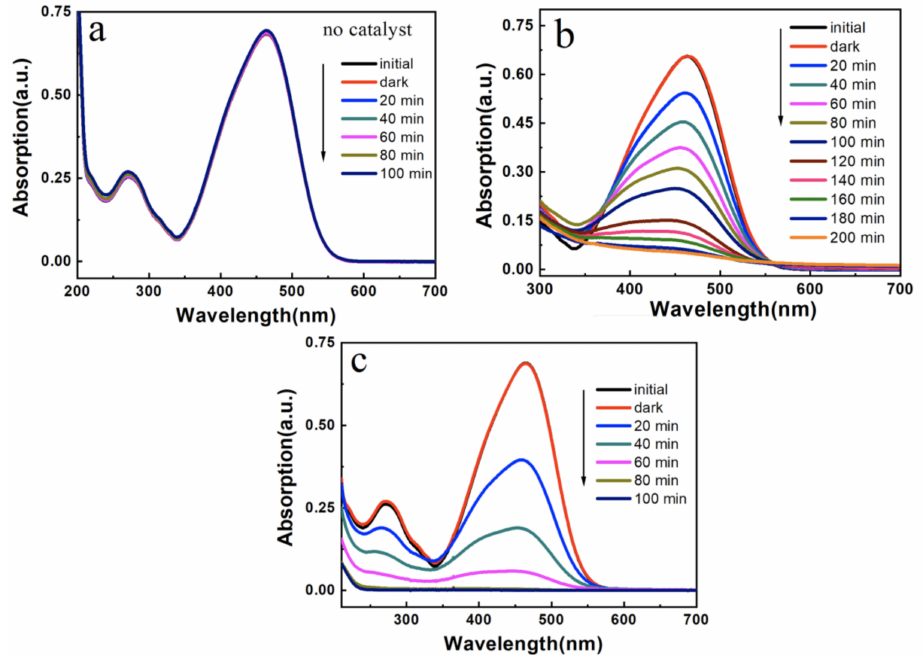
Figure 10. Photocatalytic activity of ( a ) no catalyst; ( b ) TiO 2 prepared from P. pastoris GS115 as a template; ( c ) TiO 2 -SiO 2 prepared from P. pastoris GS115 as a template for MO